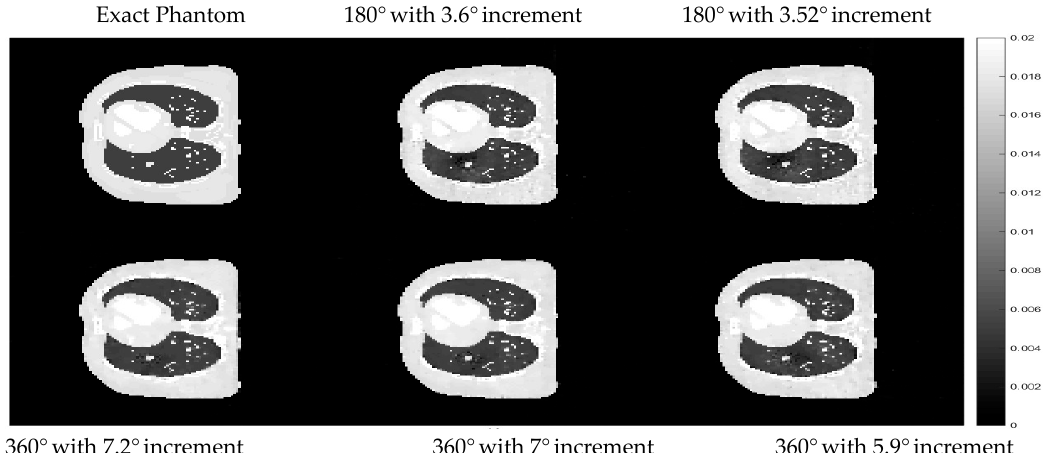
Figure 8. Cross-sectional slices of the reconstructed images with different angle arrangements. The display window is [0–0.02].